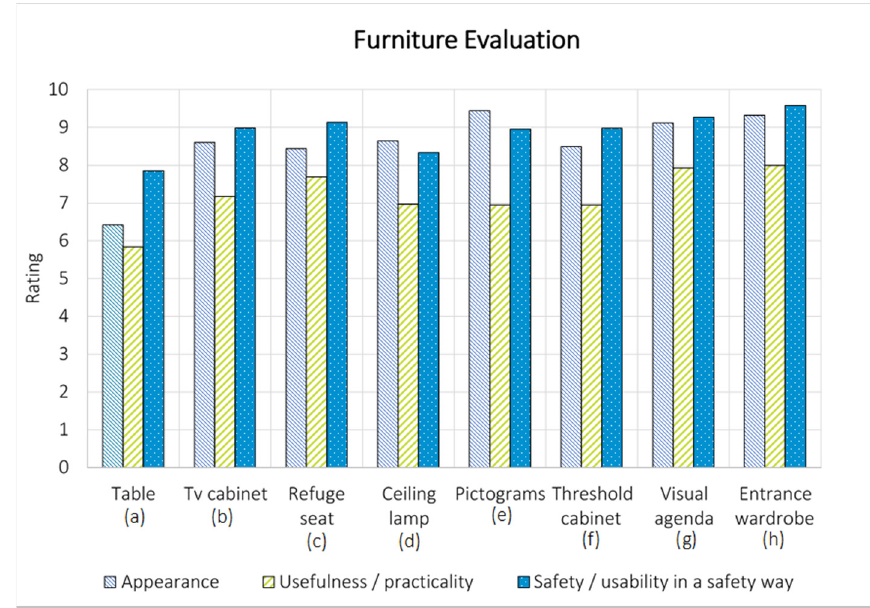
Figure 7. Rating the obtained furniture after the dedicated workshop.